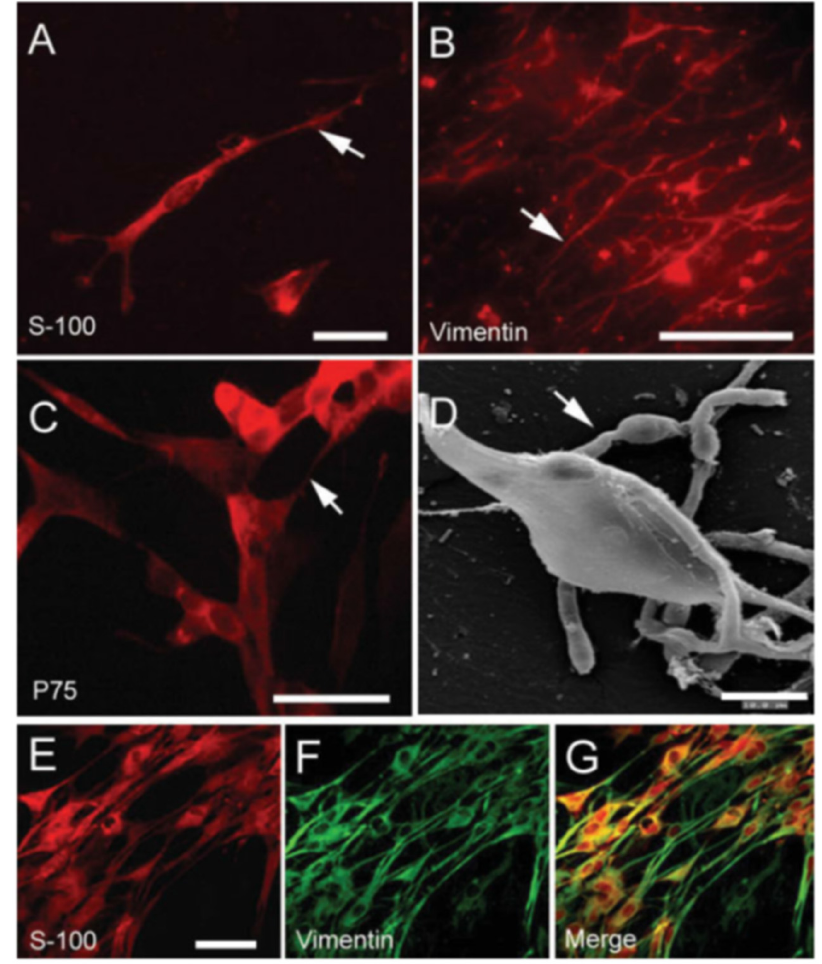
Figure 10. SCs cultured onto a P(EA-co-HEA) 90/10 substrate. Immunocytochemistry assays for the markers S100 ( A ), vimentin ( B ) and p75 ( C ); the arrow highlights a suitable cell viability of glial cells with cytoplasm extensions onto the synthetic substrate. ( D ) Scanning electron micrograph of cultured SCs with a usual spindled and shaped morphology and with cytoplasm extensions (white arrows). Double inmmunocytochemistry for S100 ( E ) and vimentin ( F ) show that almost all cultured cells (>95%) expressed both markers ( G ). Scale bar: ( A ): 50 μ m, ( B ): 100 μ m, ( C ): 60 μ m, ( D ): 10 μ m, ( E – G ): 50 μ m. Reprinted with permission from Ref [107]. Copyright 2007 Wiley Periodicals, Inc.